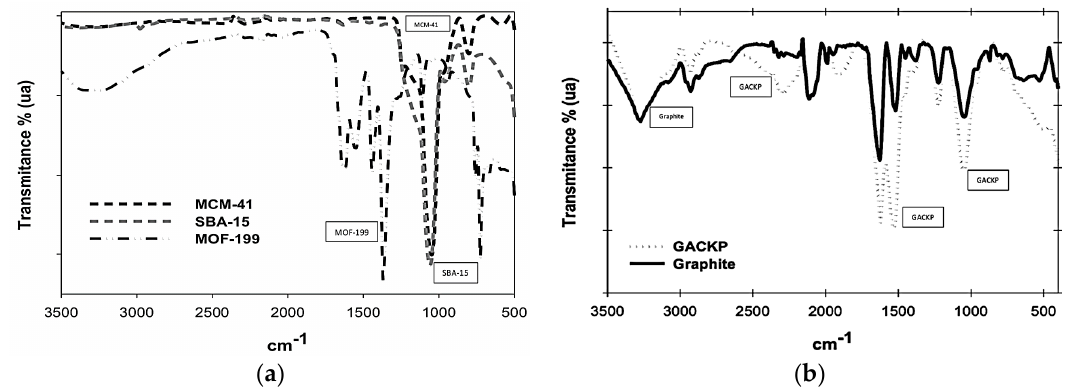
Figure 5. ( a ) FTIR spectra of MOF-199, MCM-41 and SBA-15; ( b ) FTIR spectra of GACKP and Graphite.